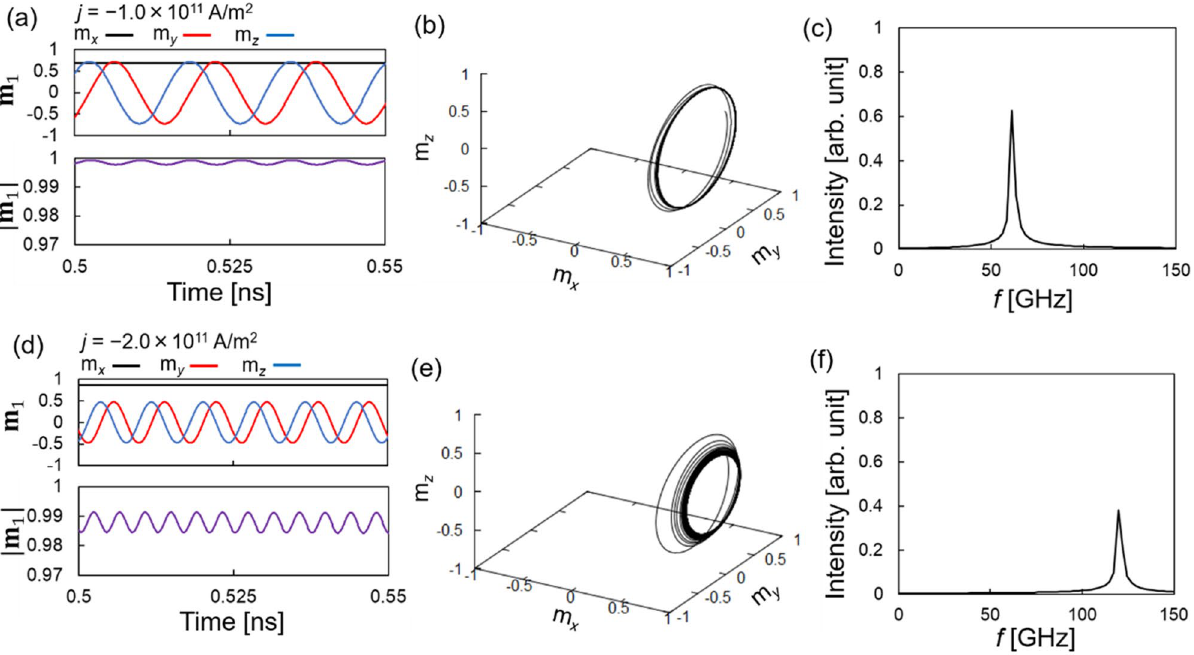
Figure 2. ( a , d ) Time evolution of averaged m 1 and | m 1 | , ( b , e ) m 1 trajectories, and ( c , f ) Fourier spectra of m 1, y for j = − 1.0 × 10 11 and − 2.0 × 10 11 A/m 2 , respectively. The interlayer exchange couplings are ( J 1 , J 2 ) = ( 0.6, − 0.6 ) mJ/m 2